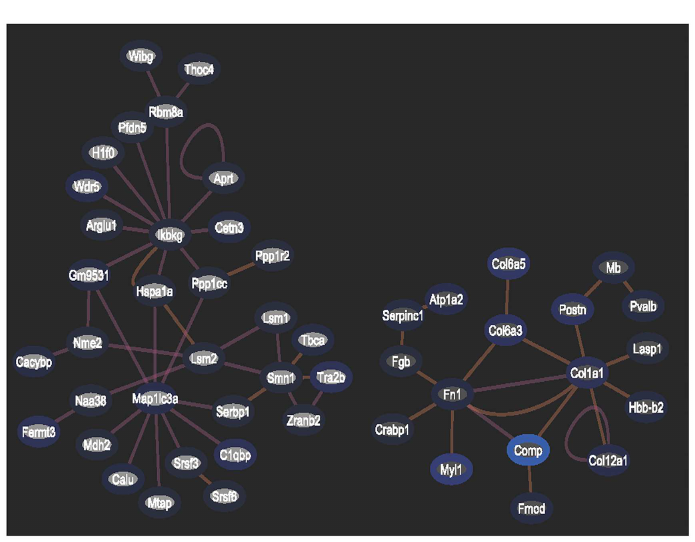
Fig 4. Network analysis of differentially expressedproteins with changes of 2.0-fold or greater in irradiated by 0.2 Gy of carbon-ion radiation with an LET of 12.6 keV/ μ m.